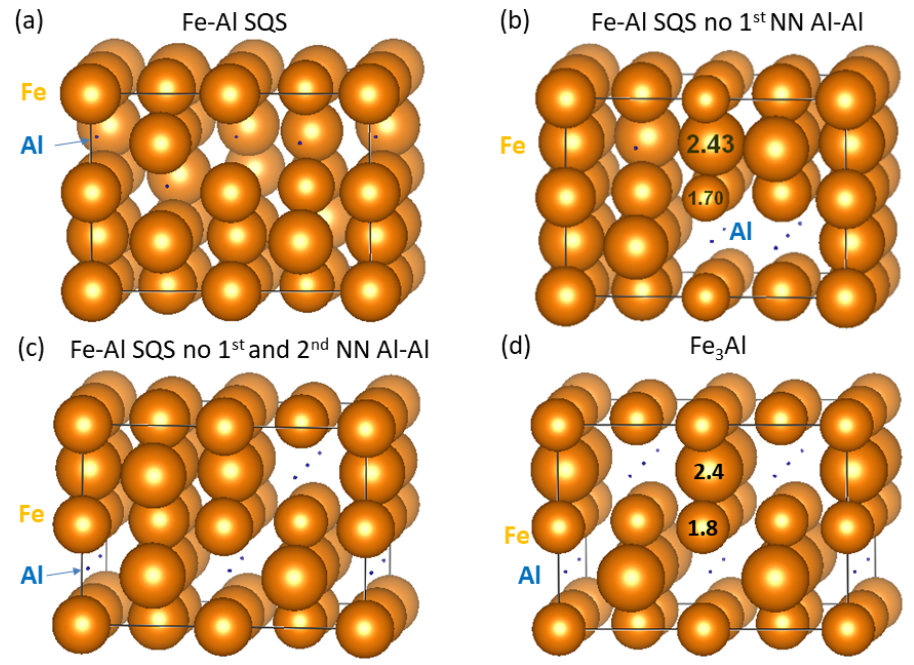
Figure 2. Schematic visualization of local atomic magnetic moments calculated for individual phases (see Figure 1): ( a – c ) are SQS models for the Fe-Al phase with different atomic arrangements and ( d ) for the Fe 3 Al. The moments are visualized so that the diameters of the spheres reflect the magnitudes of the local magnetic moments (a few examples are in parts ( b , d ) in µ B ). Magnetic moments of Al atoms are so small, less than 0.05 µ B , that they are shown only as blue